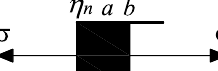
Figure 10. Schematic diagram of nonlinear viscous